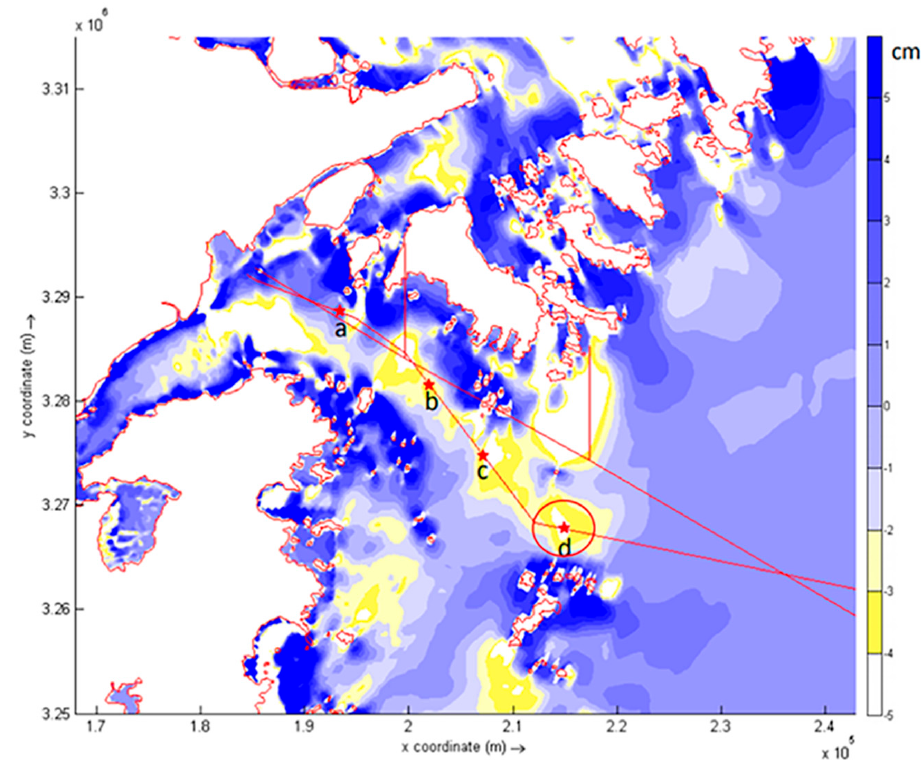
Figure 11. Regional Erosion and Deposition after Typhoon Lily.